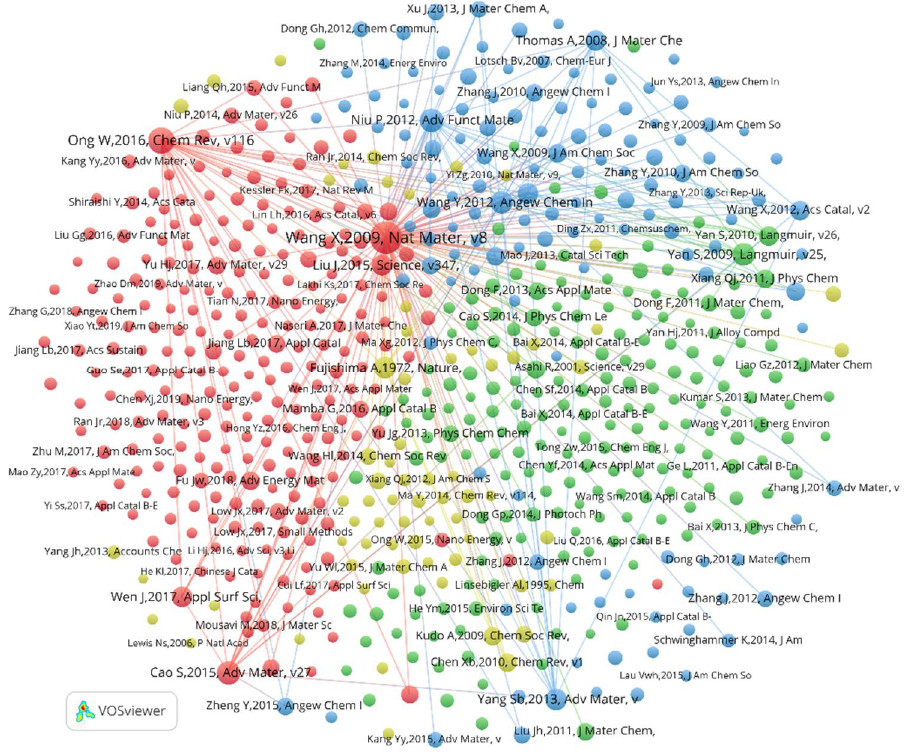
Figure 2. References co-citation network clusters of photocatalytic applications of g-C 3 N 4 .